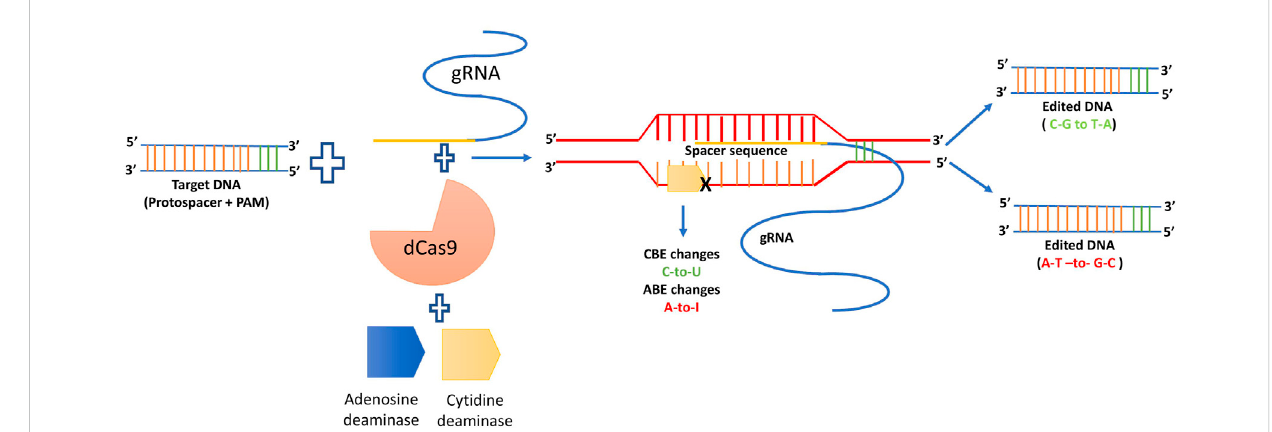
FIGURE 8 Generalized mechanism of base editing.